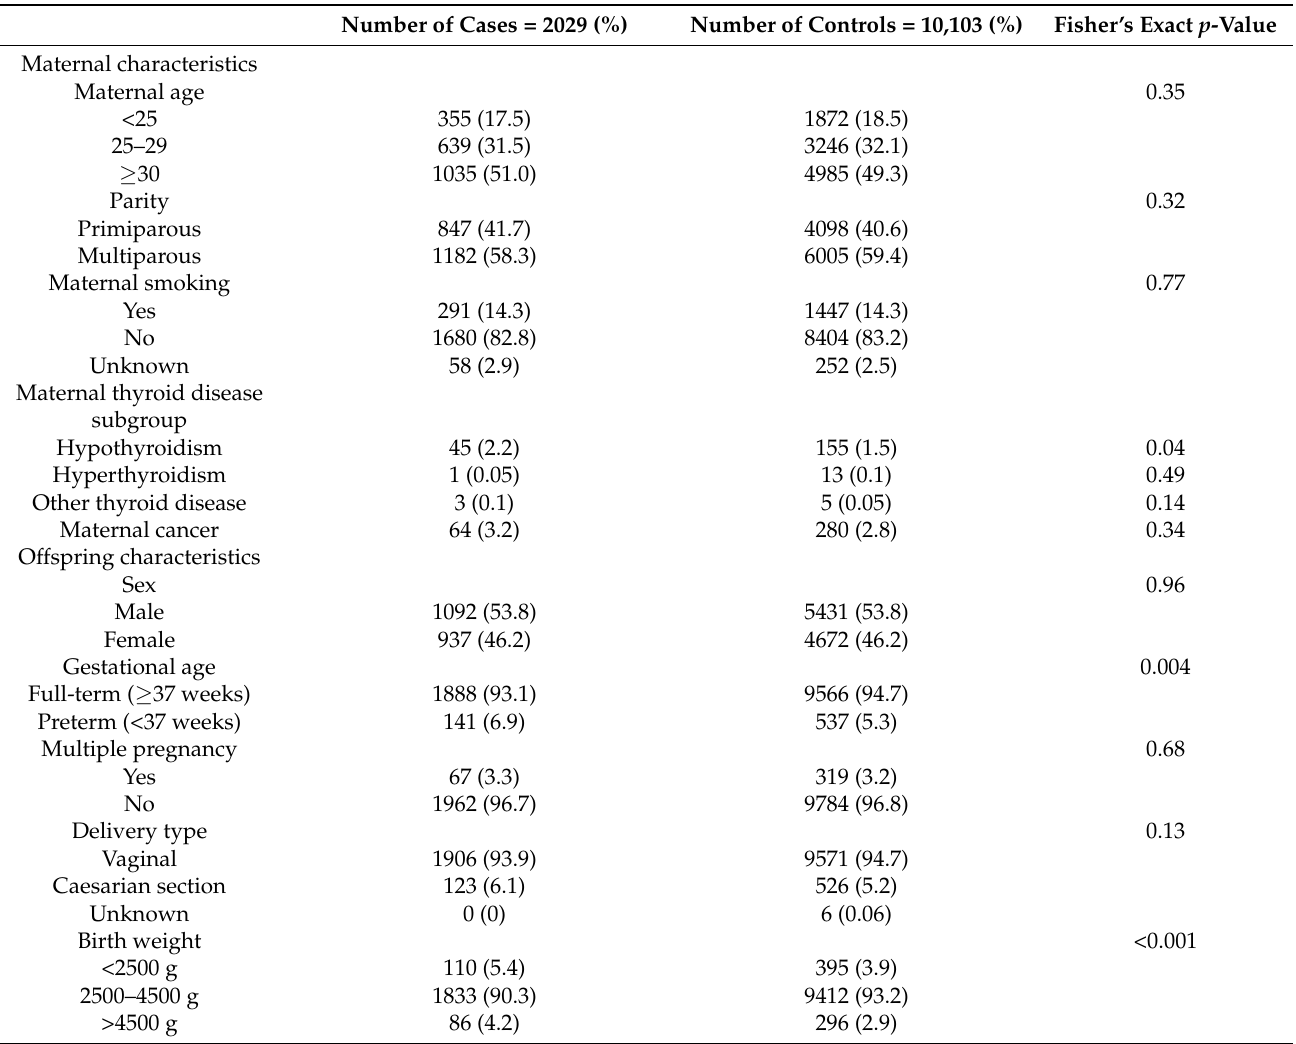
Table 1. The descriptive characteristics of the cases and controls, years 1996–2014. Number of Cases = 2029 (%) Number of Controls = 10,103 (%) Fisher’s Exact p